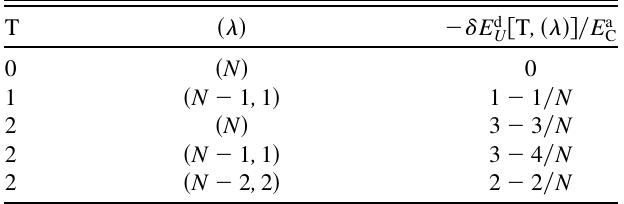
TABLE II. Energy corrections for difference-mode states due to anharmonicities ( (cid:8)H U ). T is the total number of excitations in the difference modes, and ð (cid:9) Þ is the partition labeling the irreducible